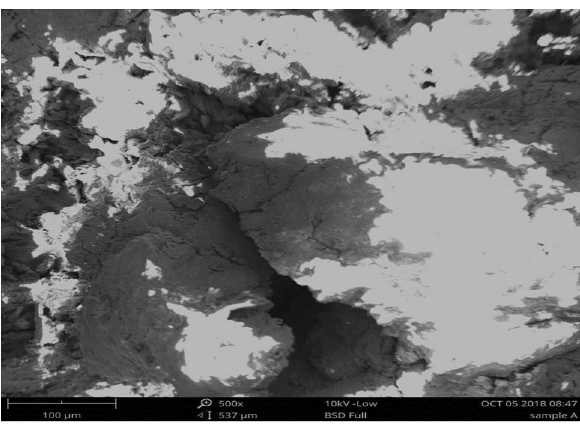
Fig. 1 Scanning electron microscopy morphology of the CS adsor-